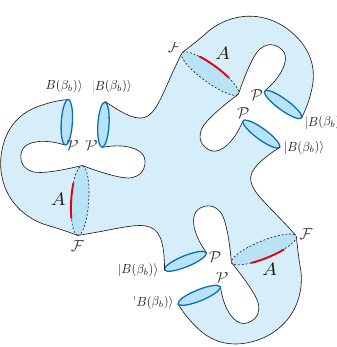
Figure 2 . The replica geometry in Schwinger-Keldysh formalism, with a replica wormhole in the ket part of the bulk. This geometry computes the pseudo entanglement entropy S ket pseudo entanglement entropy gives the desired entanglement entropy S Island assuming there are no other